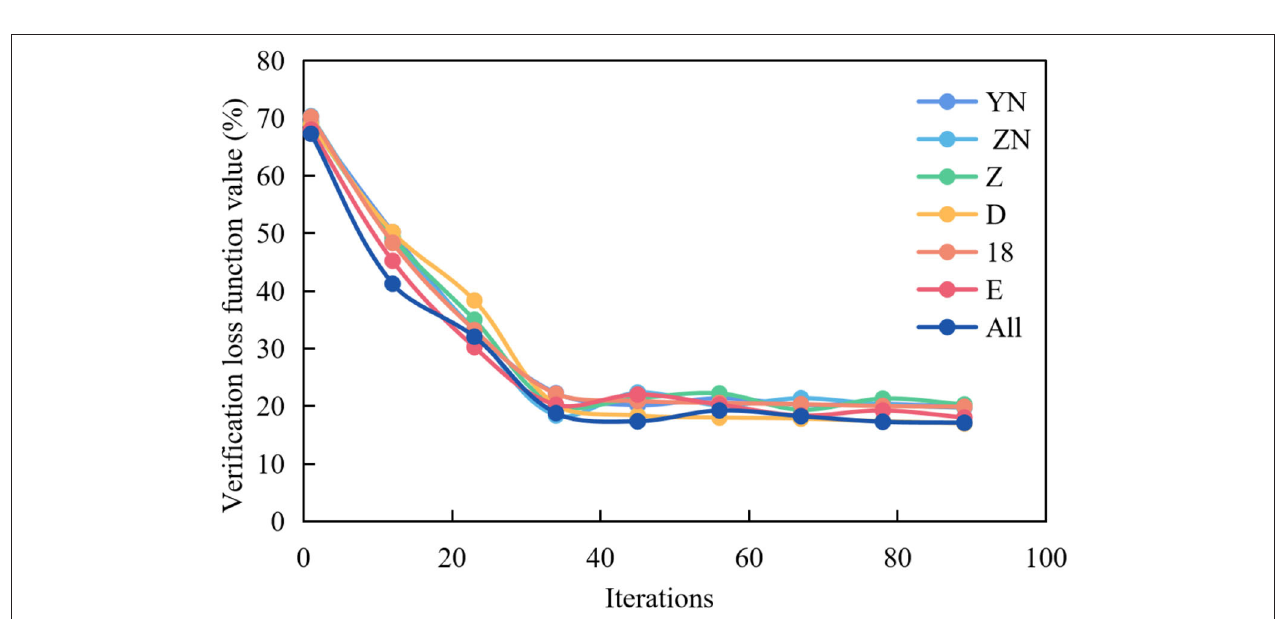
FIGURE 5 | Average verification loss function curve of multispectral image fusion in multiple brain